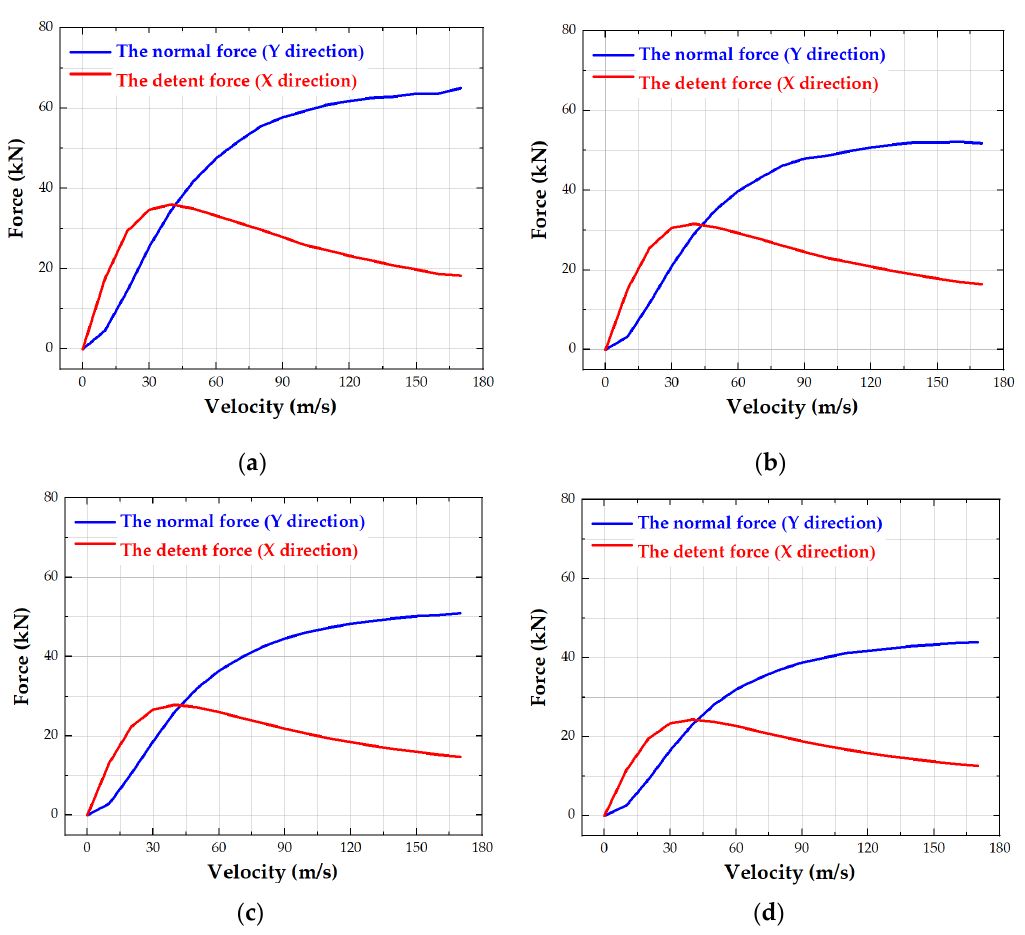
Figure 3. Relationship between the detent force, the normal force and velocity of the vehicle under different working air gaps: ( a ) under 5 mm air gap, ( b ) under 10 mm air gap, ( c ) under 15 mm air gap, ( d ) under 20 mm air gap. Table 1. The maximum detent force under different air gaps.